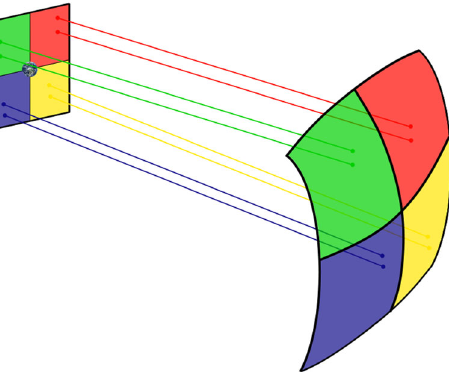
Fig. 10 Graphic representation of the trajectory of photons in the Minkowski space-time. The observer is looking directly at the celes- tial sphere, and in the absence of any gravitational field source, the path of the photons is a straight line. Therefore, in the observer’s plane, we obtain an image that corresponds with a section of the celestial sphere